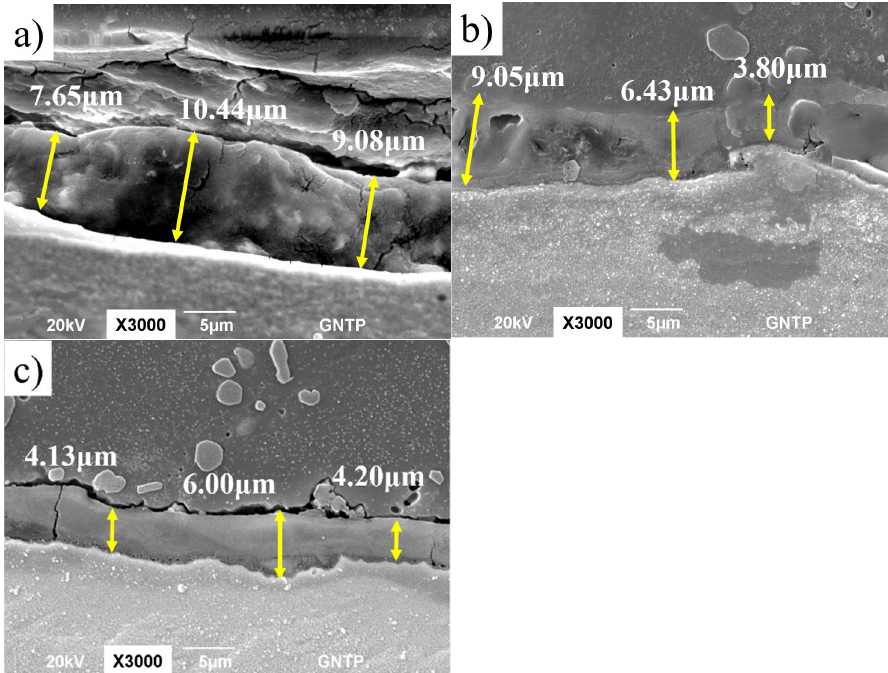
Figure 5. SEM pictures according to TPD of experiment group B. ( a ) TPD = 0.0 mm; ( b ) TPD = 0.5 mm; and ( c ) TPD = 1.0 mm. and ( c ) TPD = 1.0 mm.